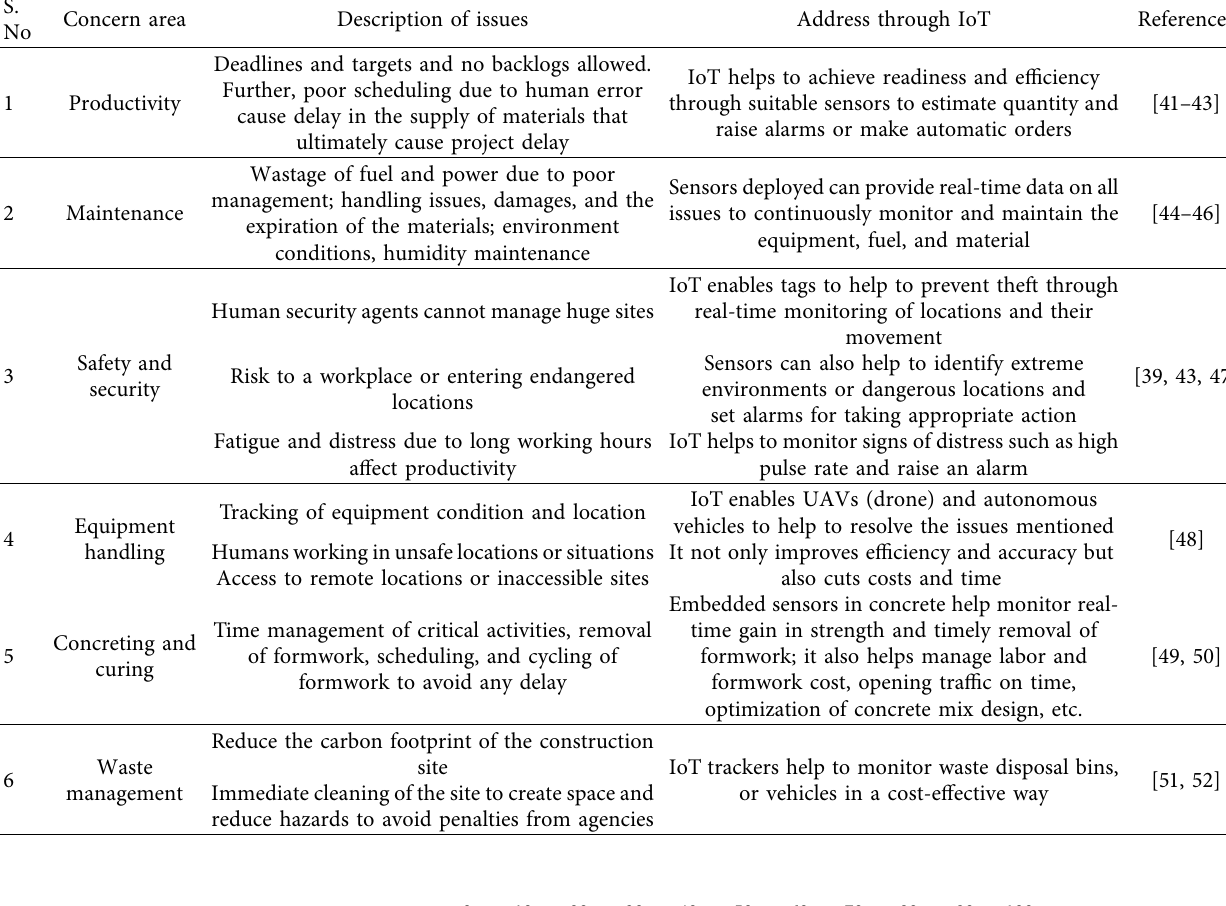
Table 2: IoT for addressing issues in key concern areas.